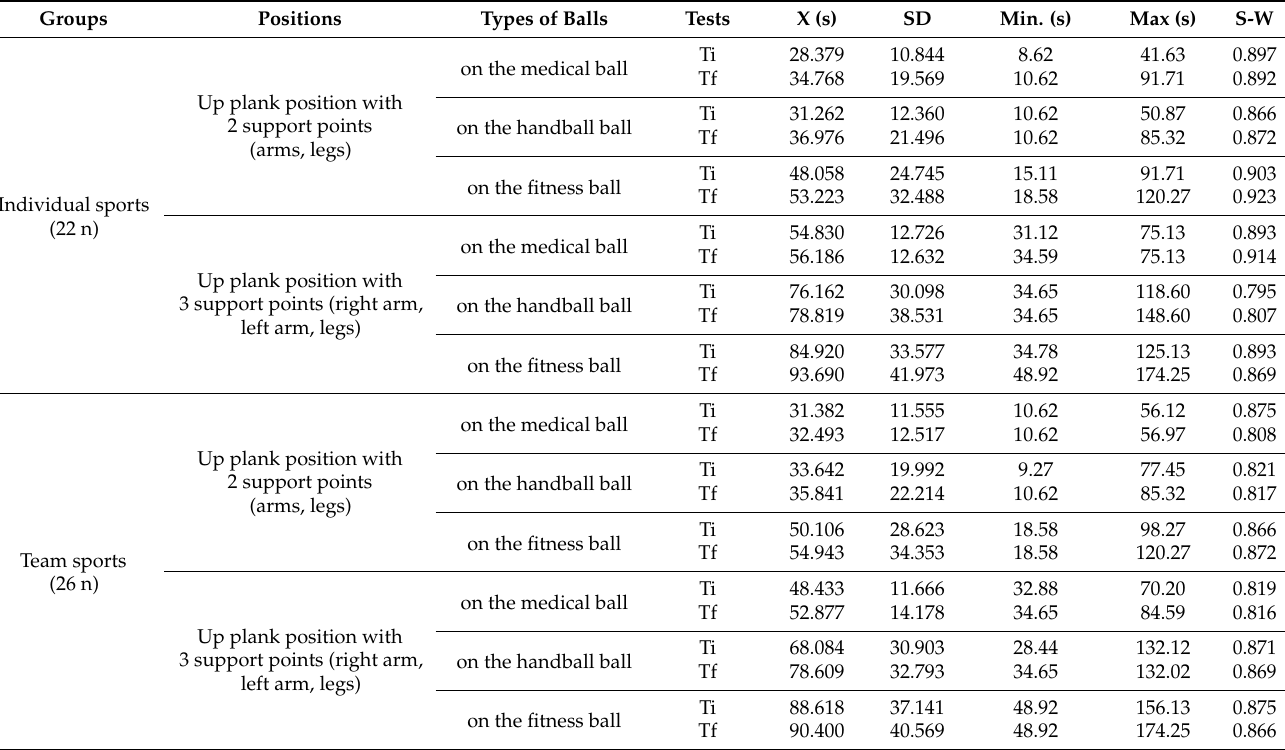
Figure 2. Mean of plank up test with 3 support points (arms, legs). The analysis of the results in Table 3, Figure 3, Figure 4, Figure 5, Figure 6, shows that the superior results were recorded in both tests on the fitness ball, and the inferior results were shown on the medicine ball. In the individual sports group, the highest value was recorded in the final test in the up plank position test with three support points (right arm, left arm, legs) on the fitness ball 93.690, and the lowest in the initial test in the up test plank position with three support points (right arm, left arm, legs) on the fitness ball 28.379. The analysis of the team sports group shows that the highest value was recorded at the final test in the up plank position test with three support points (right arm, left arm, legs) on the fitness ball 90.400, and the lowest at the initial test at the test up plank position with three support points (right arm, left arm, legs) on the fitness ball 31.382. The distribution of the results was normal, according to the S-W results, which ranged between 0.795 and 0.923. All results in both initial and final tests for both groups were statistically significant. Table 3. Differences between initial and final tests of physical tests of maintaining balance on the three types of balls in the up plank position—individual sports group and team sports group.